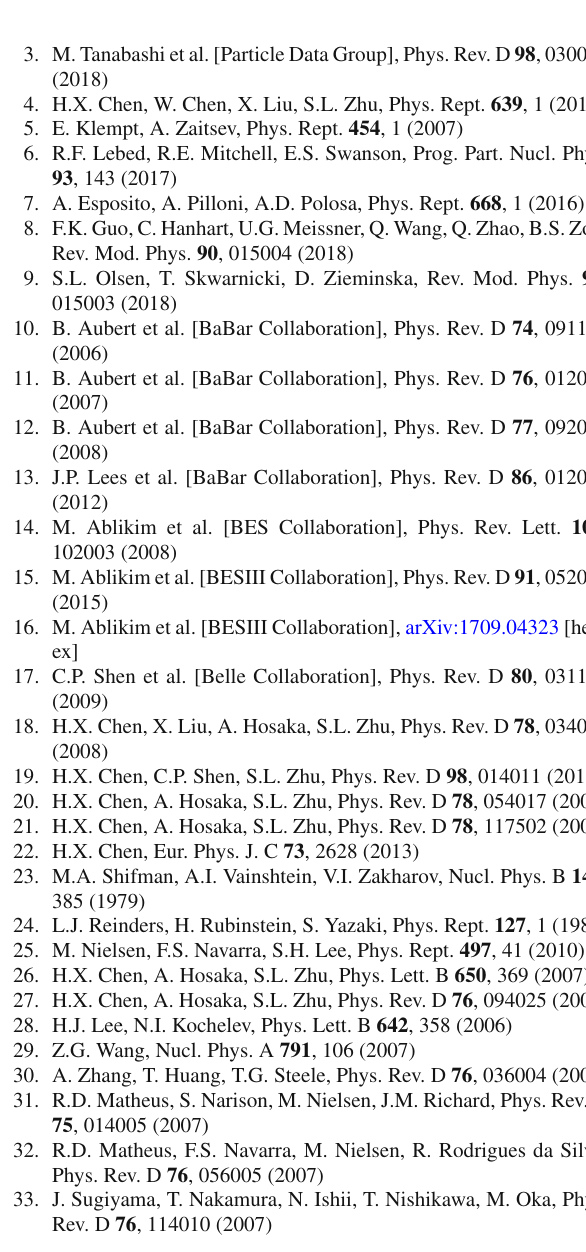
Table 1 Masses extracted from the vector and axial-vector tetraquark currents. Possible experimental candidates are listed for comparisons. We use q to denote an up or down quark, and s to denote a strange quark. The mass value 2 . 00 + 0 . 10 −